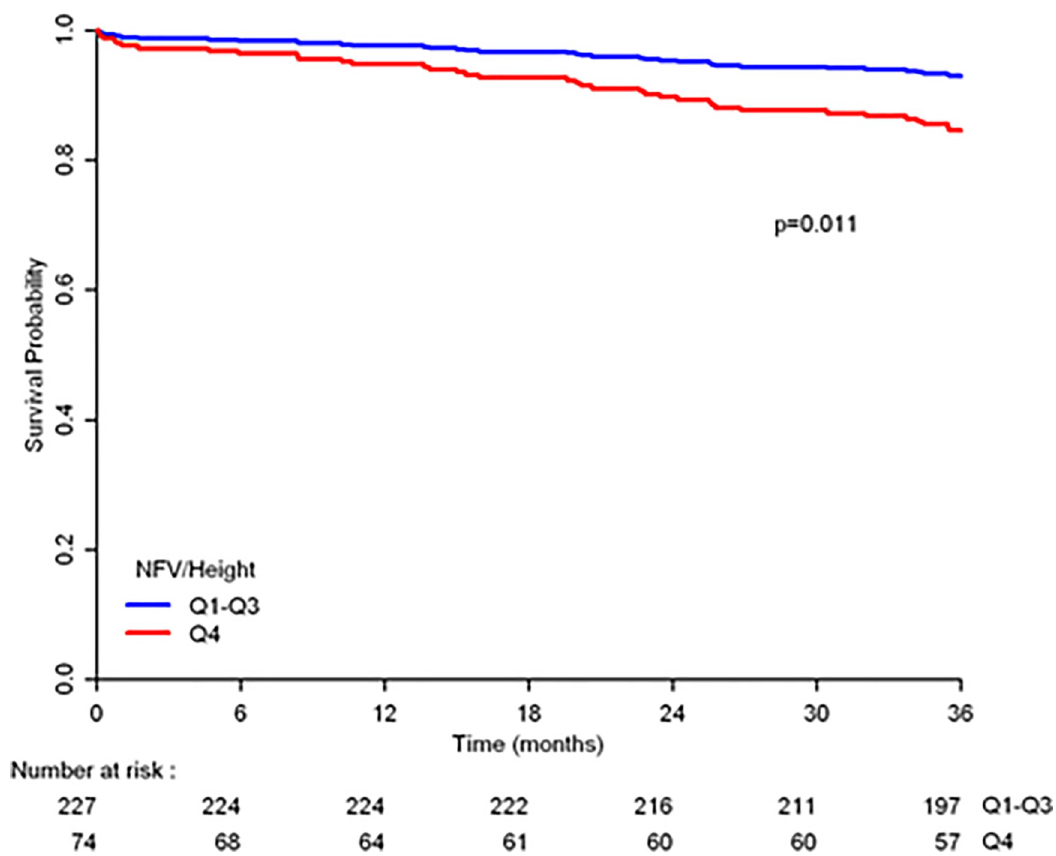
Fig 1. Kaplan-Meier analysis for all-cause mortality stratified by NHR quartiles.